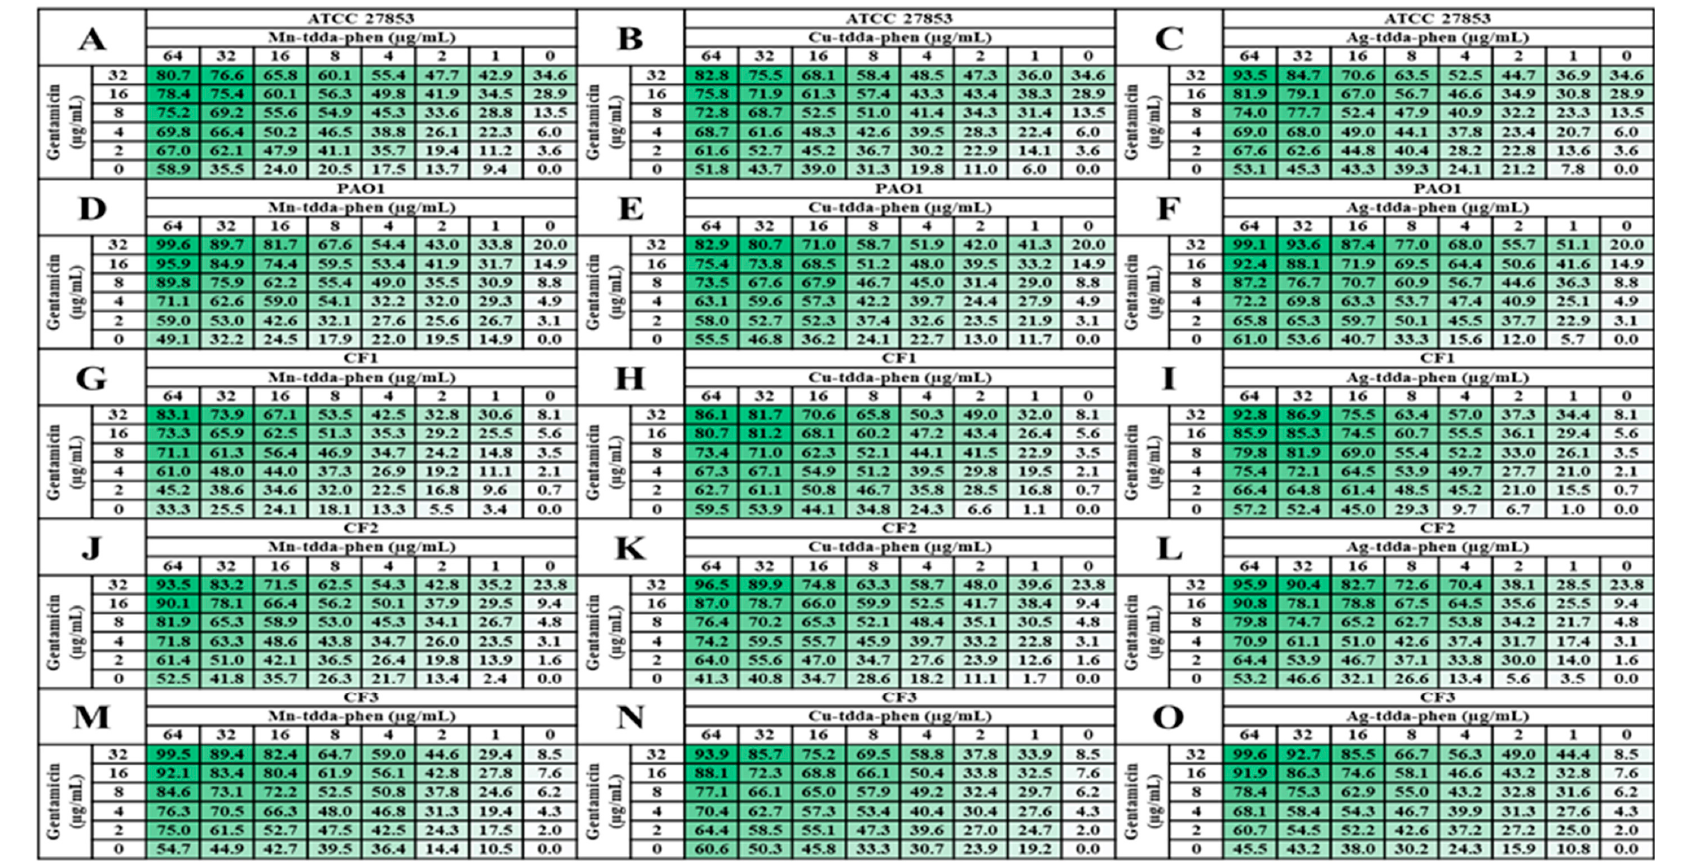
Figure 3. Heat map representation of percentage of biofilm removal of 48 h established biofilms of reference strains, ATCC 27853 and PAO1, and clinical isolates, CF1-CF3, by combinations of metal-tdda-phen complexes with gentamicin. Mn-tdda-phen and gentamicin (A,D,G,J,M); Cu-tdda-phen and gentamicin (B,E,H,K,N); Ag-tdda-phen and gentamicin (C,F,I,L,O). Heat map shows the percentage of biofilm removed with respect to untreated sample.